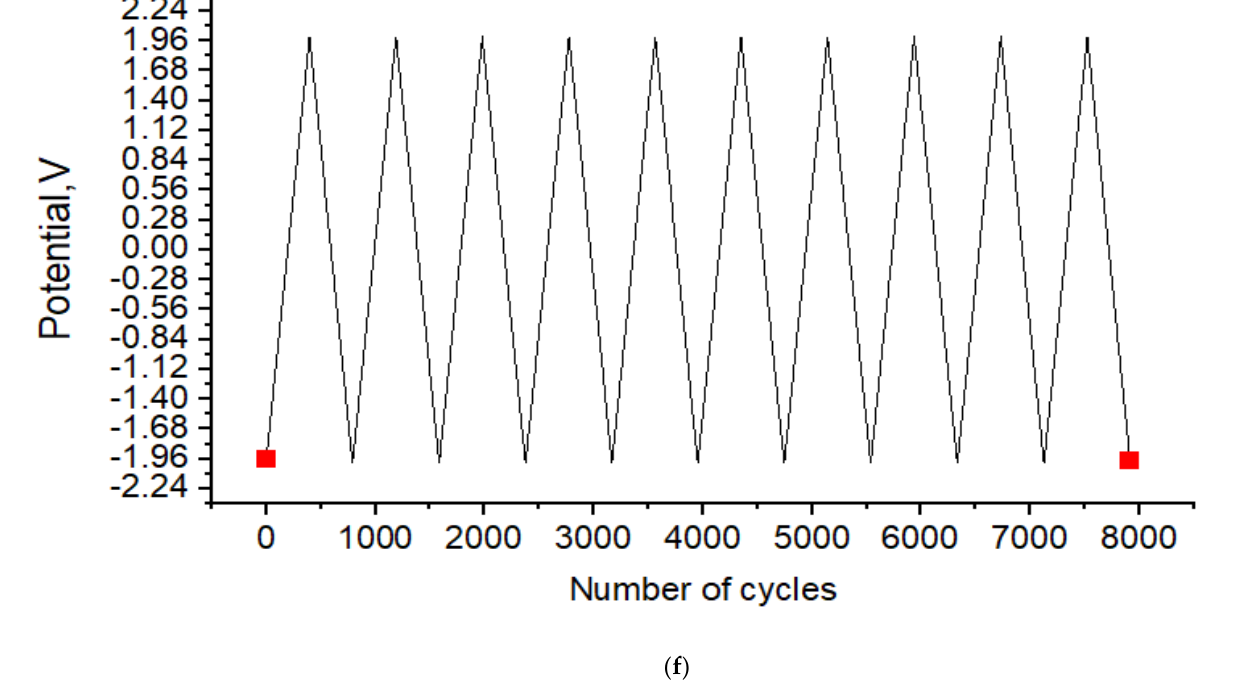
Figure 8. Electrochemical measurements: ( a , b ) cyclic voltammetry of all nanoparticles, ( c ) cyclic voltammetry of CuO nano-particles, ( d ) cyclic voltammetry of GO nano-particles, and ( e , f ) statistical stability and number of cycles of stable charge-discharge.